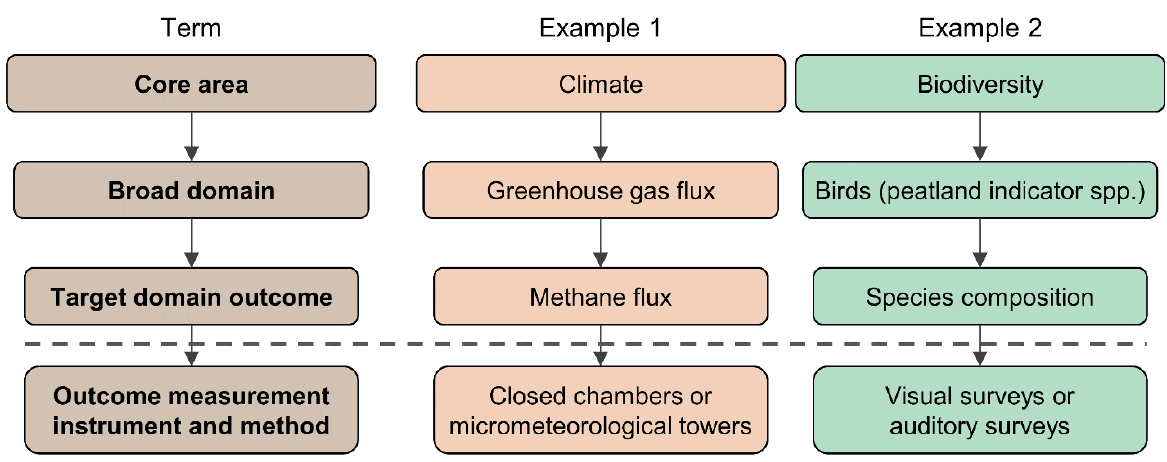
Figure 1. Conceptual organisation of core areas, domains and outcomes - which are prioritised and short- listed to define core domain sets of the minimum set of broad domains and target domain outcomes that should be measured - showing examples from peatlands, based on this research. The scope of the work reported here is shown above the dashed line. Future research could identify the method and outcome measurement instruments for each of the outcomes that this research has prioritised in the core domain